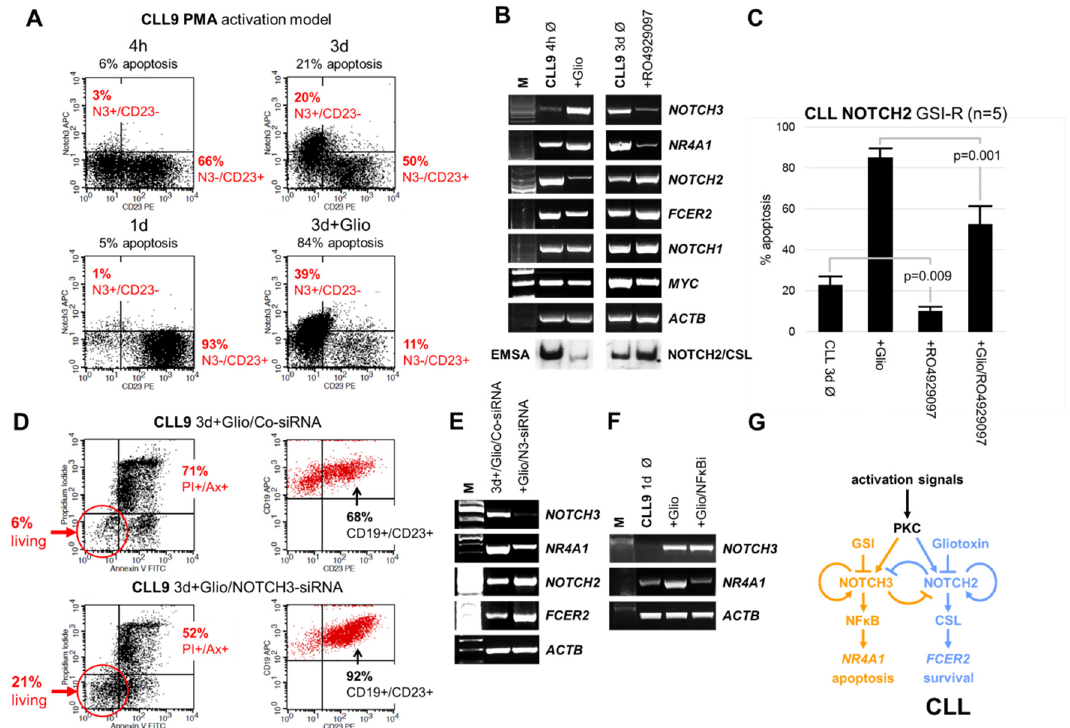
Figure 5. NOTCH3 inhibition counteracts apoptosis in PMA-activated CLL cells. ( A ) FACS analysis indicating the time-dependent effect of PMA (1 ng/mL) on surface NOTCH3 and CD23 expression in CLL9 cells. ( B ) Corresponding RT-PCR showing the opposite effects of gliotoxin (0.2 µM) and RO4929097 (0.5 µM) on the NOTCH2/FCER2 (CD23) axis and the NOTCH3/NR4A1 axis in PMA-activated CLL9 cells. The mRNA expression of the CLL proliferation center marker MYC is indicated [41,42]. ( C ) FACS analysis demonstrating the inhibition of spontaneous/gliotoxin induced apoptosis by RO4929097 in NOTCH2 GSI-R CLL cells. ( D ) NOTCH3 -siRNA counteracted gliotoxin induced apoptosis in PMA-activated CLL9 cells and enhanced surface CD23 expression on the remaining living cells. ( E ) Corresponding RT-PCR showing the opposite effects of NOTCH3 gene silencing on the NOTCH3/NR4A1 axis and on the NOTCH2/FCER2 axis. ( F ) RT-PCR showing the inhibition of gliotoxin induced NR4A1 mRNA expression by 0.1µM NF κ B activation inhibitor (NF κ Bi). ( G ) Hypothetical model summarizing the proposed counteracting roles of NOTCH2 and NOTCH3 in CLL cells. Non-canonical NOTCH3 signaling which involves NF κ B dependent NR4A1 expression is shown in yellow color. Canonical NOTCH2 signaling which involves CSL dependent FCER2 (CD23) expression is marked in blue. The NOTCH2 dominance in CLL is indicated. Positive and negative feedback loops of NOTCH receptor expression and function are indicated with circular arrows and bars.